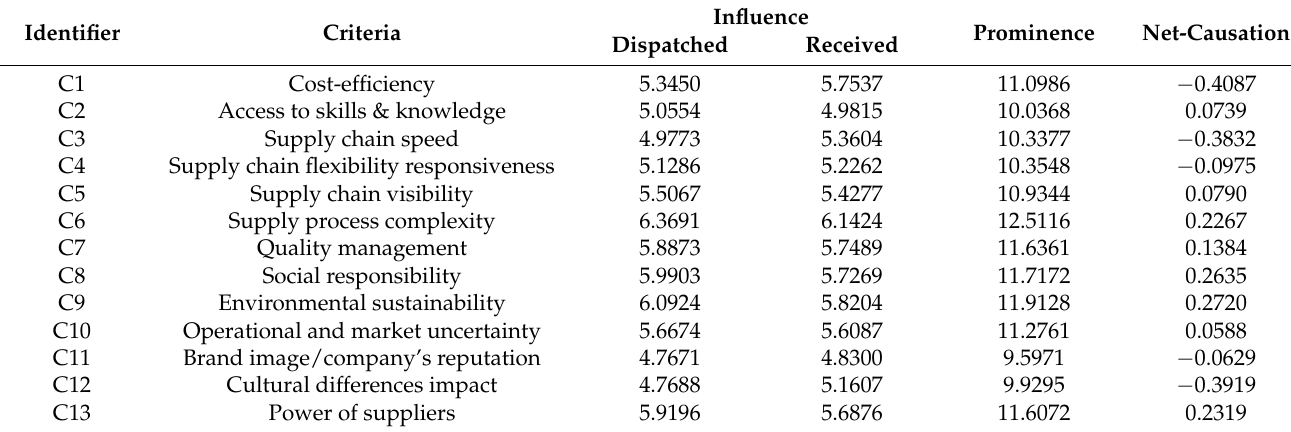
Table 4. Results analysis of the reshoring